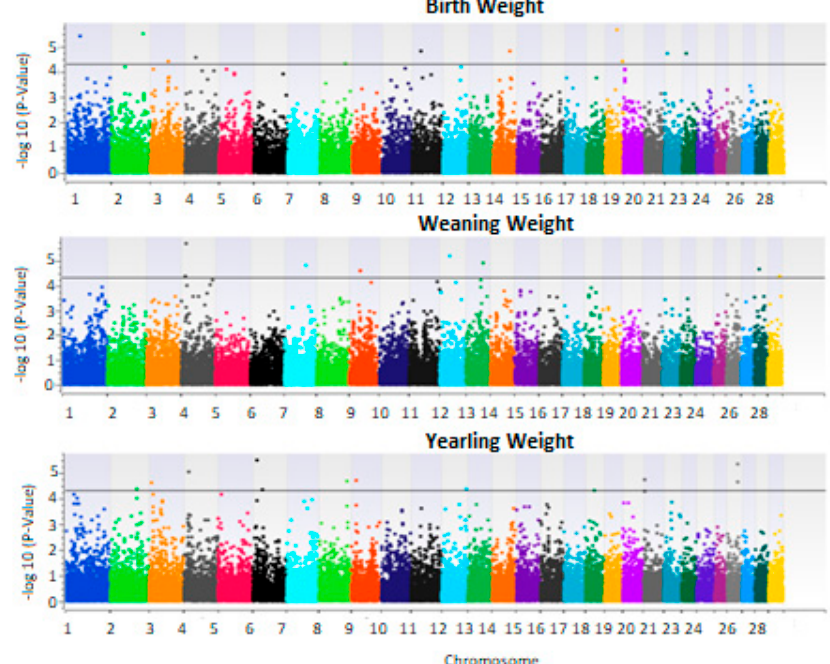
Figure 4. Manhattan plot of genome wide association analysis results of dominance effects using EMMAX for birth, weaning and yearling weights. X-axis represents chromosomal locations and Y-axis is − log10 of p -values. The black line is − log10 (5e − 5) .